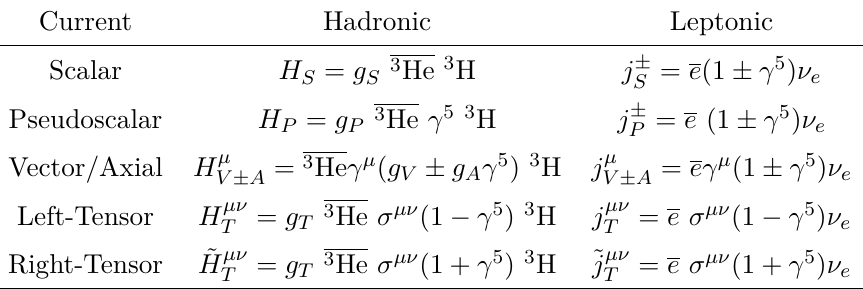
Hadronic and leptonic currents expanded in the basis of gamma matrices with σ µν = i [ γ µ , γ ν ] 2